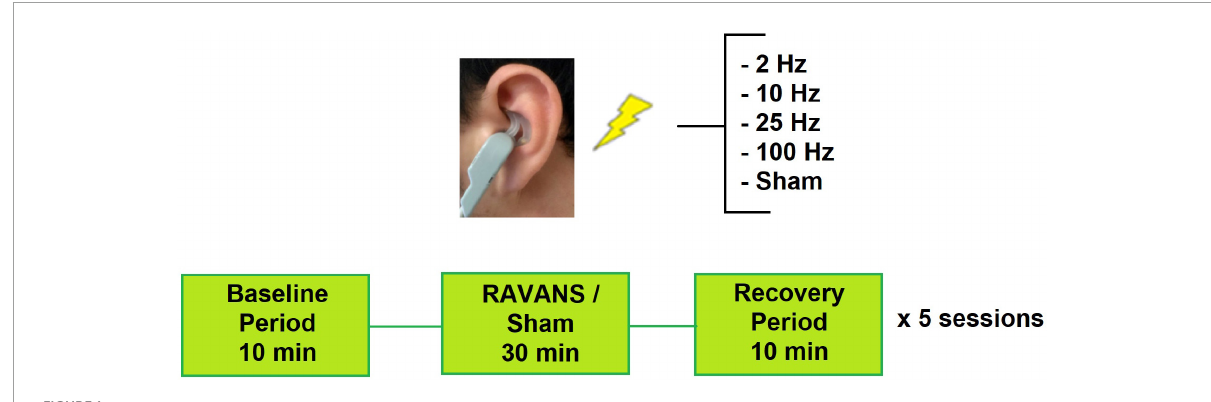
FIGURE1 Experimental setup for study sessions. Subjects attended 5 sessions and receive one RAVANS frequency per